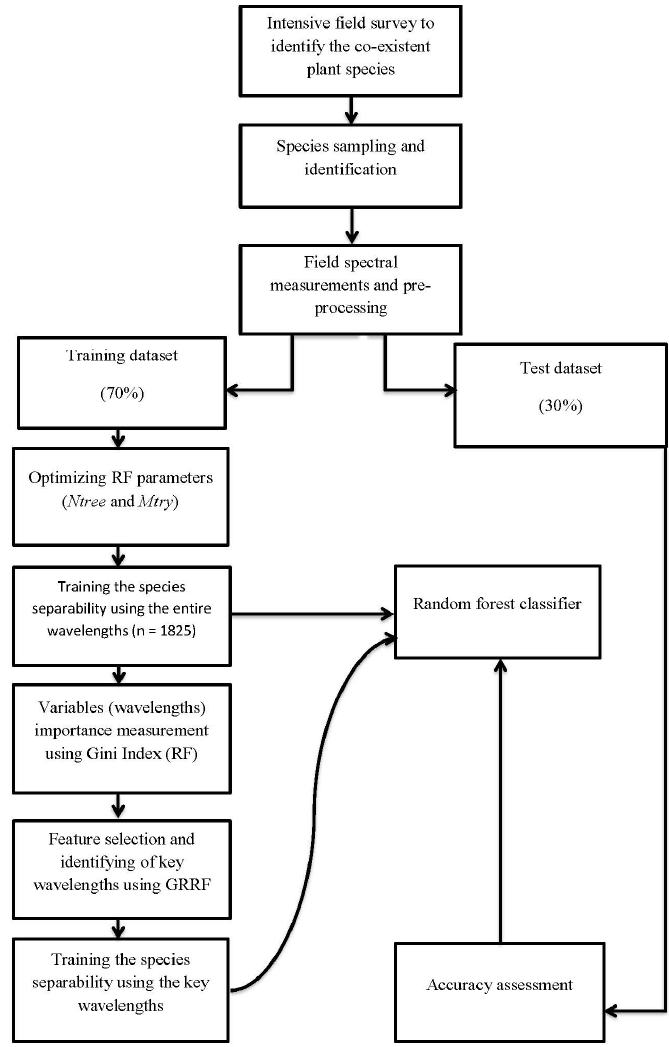
Figure 3. Flowchart describing the random forest (RF) and guided regularized random forest (GRRF) models used in this study.